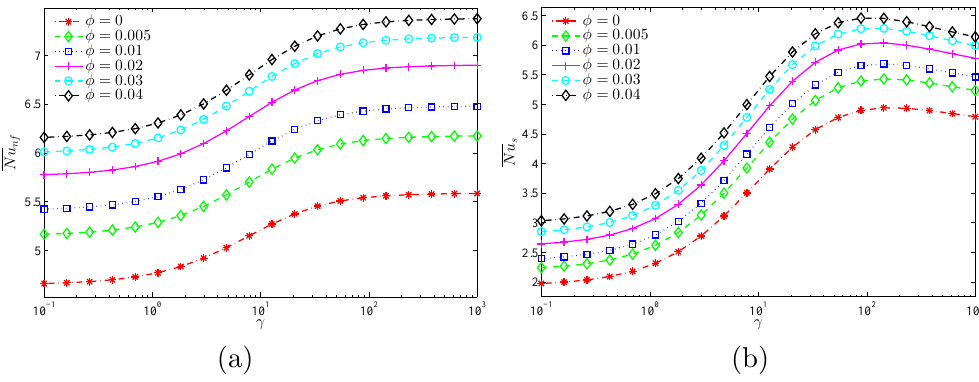
Figure 14. Variations of ( a ) the average Nusselt number of the nanofluid phase and ( b ) the average Nusselt number of the solid phase γ for different φ values at Da = 10 − 3 , N = 3, and ε = 0.5. Figures 15 and 16 show that the largest global heat transfer for both the solid and nanofluid phases is found for the highest undulation amplitude ( A = 0.2) for all tested values of Da and φ . This can be attributed to the large heat exchange surface of the wavy wall for high values of A . In addition, at a given A , the values of the Nu nf and Nu s are found to increase with increasing values of Da and φ .